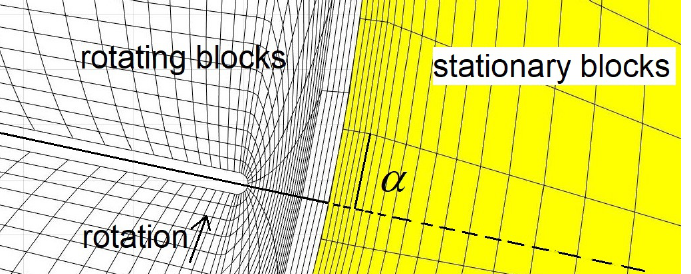
Figure 1. Diagram of the sliding interface, showing the relative displacement angle α between a rotating block and other static ones (particular